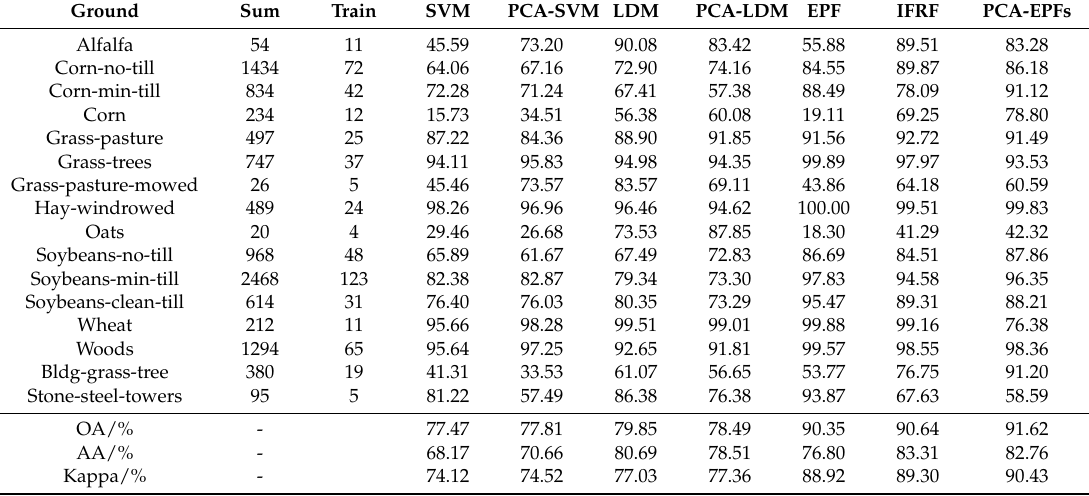
Table 1. Comparison of classification accuracies (in percent) provided by seven methods for Indian Pines (part A).